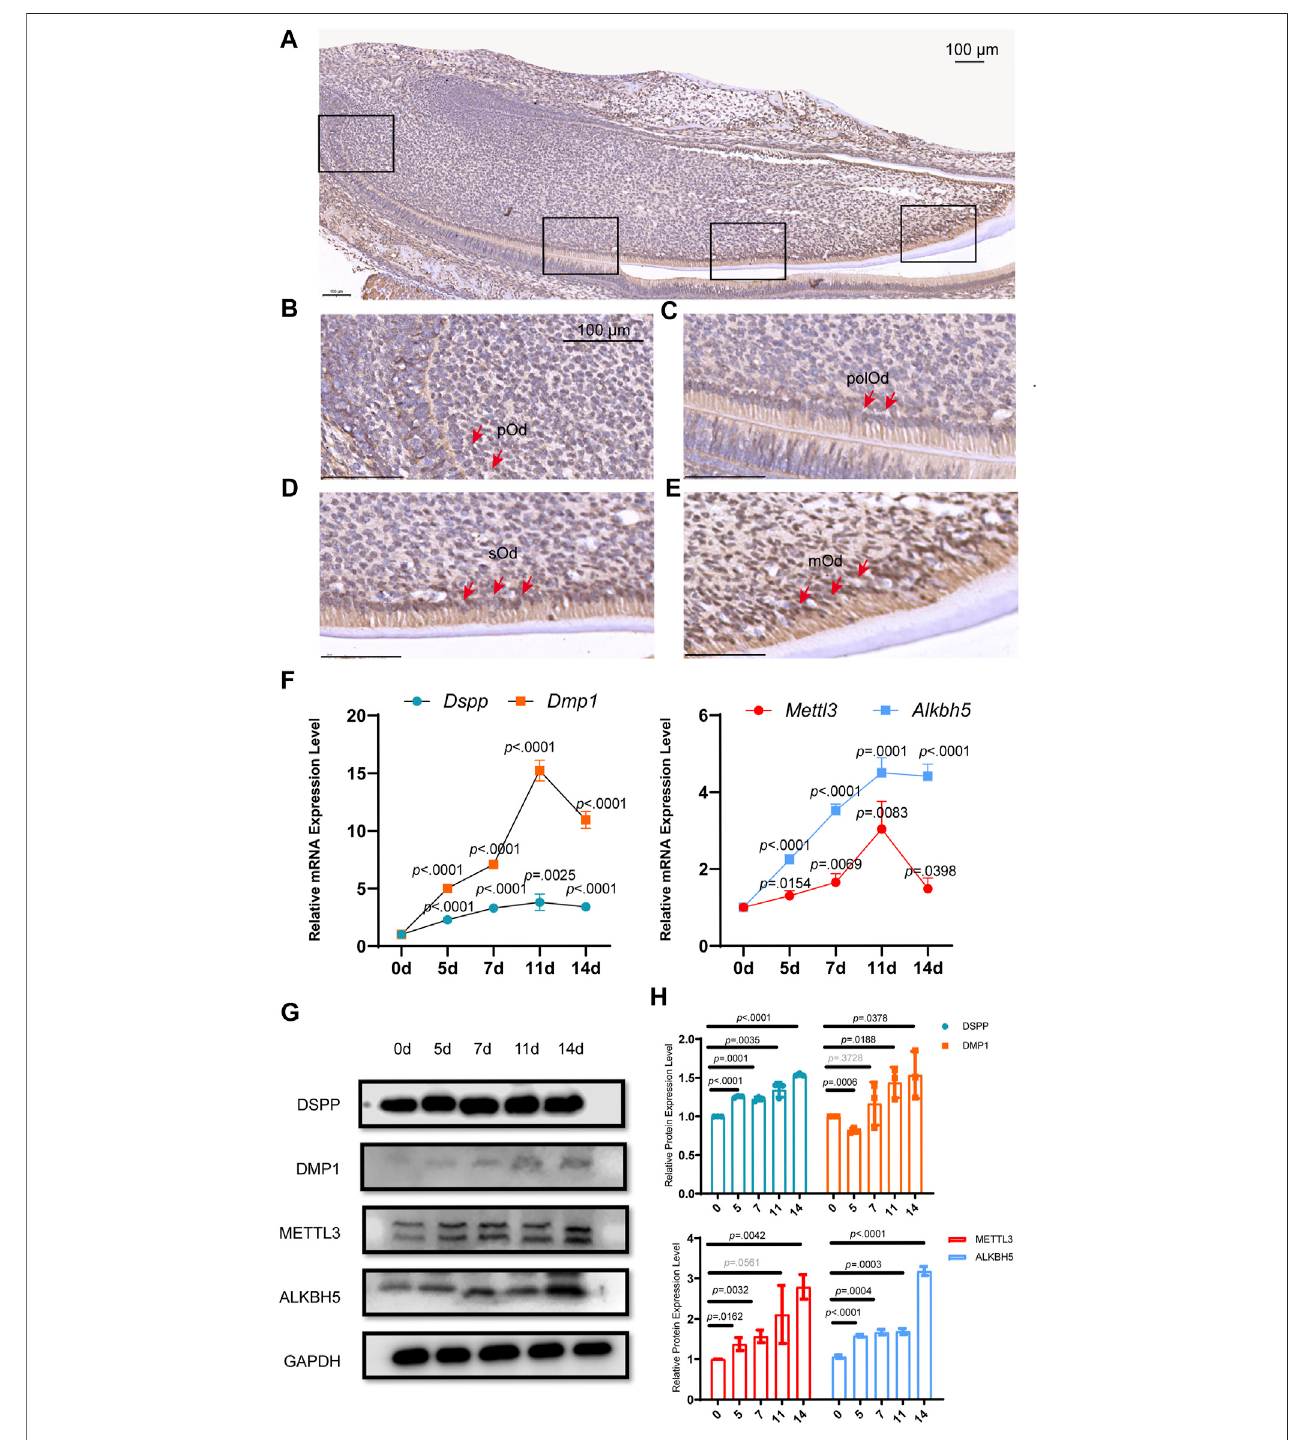
FIGURE1| Alkbh5 wasupregulated during mouse odontoblast differentiation invivo and in vitro . (A) Immunohistochemistry analysisoftheexpression ofALKBH5 in the PN2.5 murine mandibular incisors. ALKBH5 protein expression was low in (B) pOd and was strongly expressed in (C) polOd (D) sOd, and (E) mOd. (F) The odontoblast markers Dspp and Dmp1 , and m 6 A methylase Mettl3 and demethylase Alkbh5 were upregulated after induction. (G) The protein expression levels of METTL3, ALKBH5, DSPP, and DMP1 were signi fi cantly increased. (H) Quanti fi cation of the DMP1, DSPP, METTL3, and ALKBH5 protein expression level during odontoblastinduction. (A – E) Scalebar:100 μ mAlkbh5,AlkBhomologH5;pOd,pre-odontoblasts;polOd,polarizingodontoblasts;sOd,secretoryodontoblasts;mOd, mature odontoblasts; Dspp, dentin sialophosphoprotein; Dmp1, dentin matrix acidic phosphoprotein 1; Mettl3, methyltransferase-like 3; PN2.5, postnatal day 2.5.